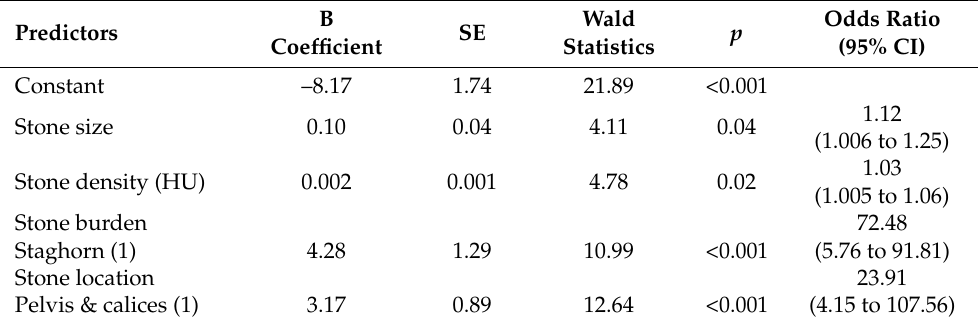
Table 3. Results from the multivariate binary logistic regression for factors that are significantly associated with a residual-stone outcome.